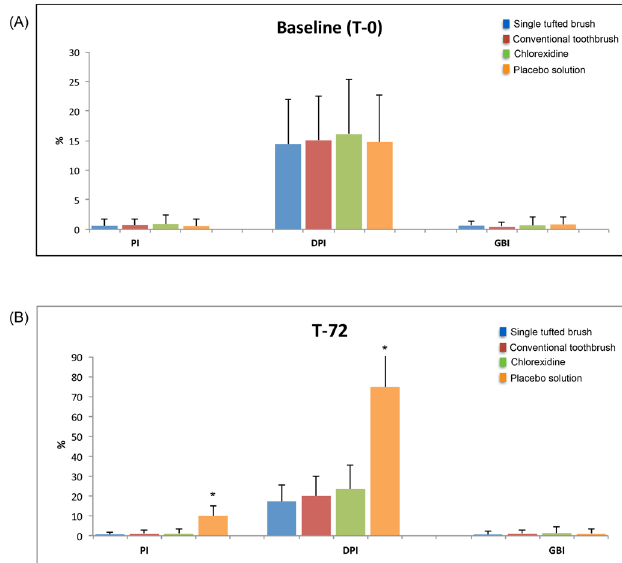
Fig.2. Mean (±SD) for the clinical parameters at baseline (T-0) (A), and after 72 h (B) for single-tuft brush (STB), conventional toothbrush (CT), chlorhexidine (CHX) and placebo solution (SP). * indicate significant intragroup differences for the clinical parameters evaluated, by Anova and Tukey test (p <0.05).